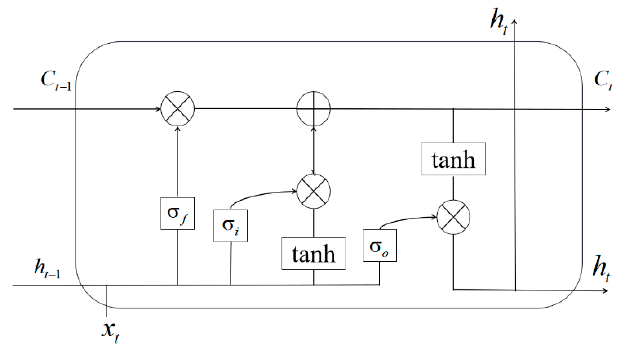
Figure 3. The network structure of LSTM model.